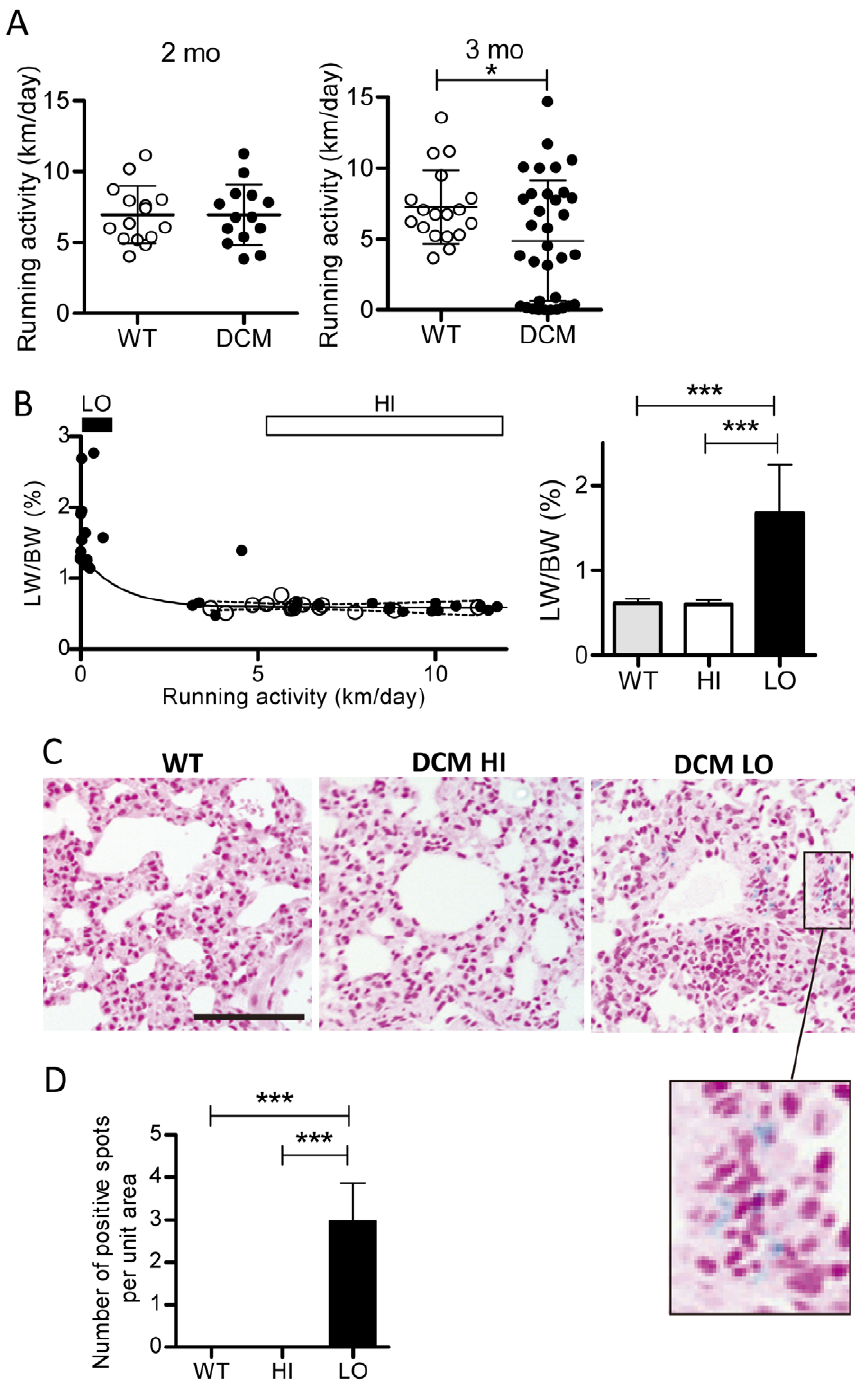
Figure 2. Relationship between running activity and LW/BW ratio and histological lung sections stained with Berlin blue. A . Running activity of WT and DCM mice at 2 (left) and 3 months of age (right). Bars are mean 6 SD. B . Relationship between running activity and LW/HW ratio in mice at approximately 3 months of age and average running activities in WT, DCM with high ( . 5 km/day, denoted ‘‘HI’’) and low ( , 1 km/day, denoted ‘‘LO’’) running activities (Left). Note that DCM mice (filled circles) with running activity of . 5 km/day (HI) and all WT mice (open circles) showed similar LW/BW ratios, approximately 0.6% on average, whereas LW/BW ratios in all DCM mice with running activity of , 1 km/day (LO) showed LW/BW ratios of . 1%. C . Representative images of Berlin blue-stained lung sections from WT and HI and LO groups of DCM mice. Berlin blue-positive macrophages are detected only in sections from DCM mice with low activity. Bar indicates 100 m m. Inset: enlarged image. D. Average numbers of Berlin blue-positive alveolar macrophages per field of view of 0.2 6 0.25 mm 2 . Error bars are mean 6 SD ( n =4–5).